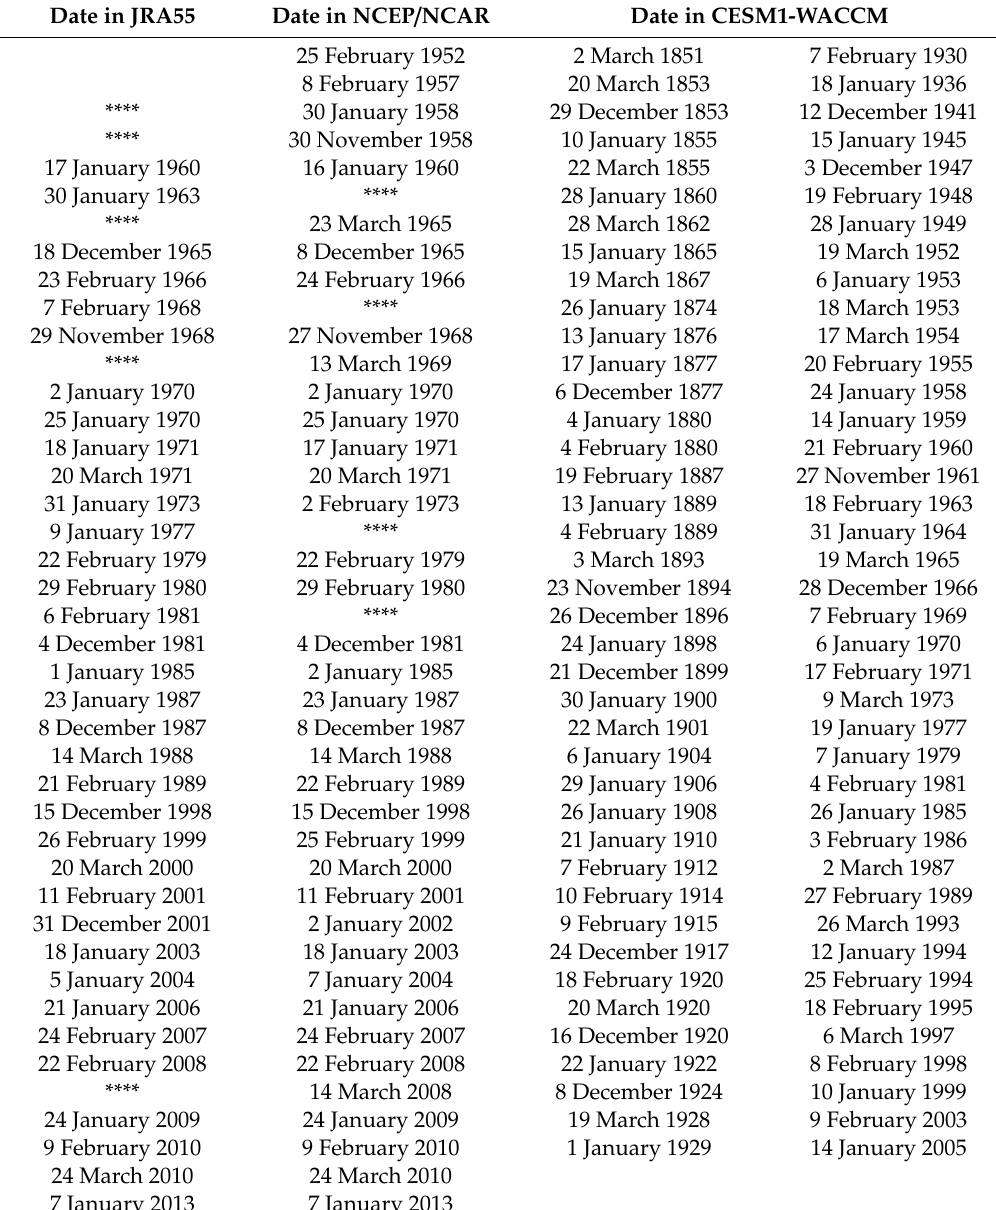
Table 1. Onset dates of sudden stratospheric warmings (SSW) events in the JRA55 and NCEP / NCAR reanalyses (1958 / 1948–2015) and in the CESM1-WACCM historical run